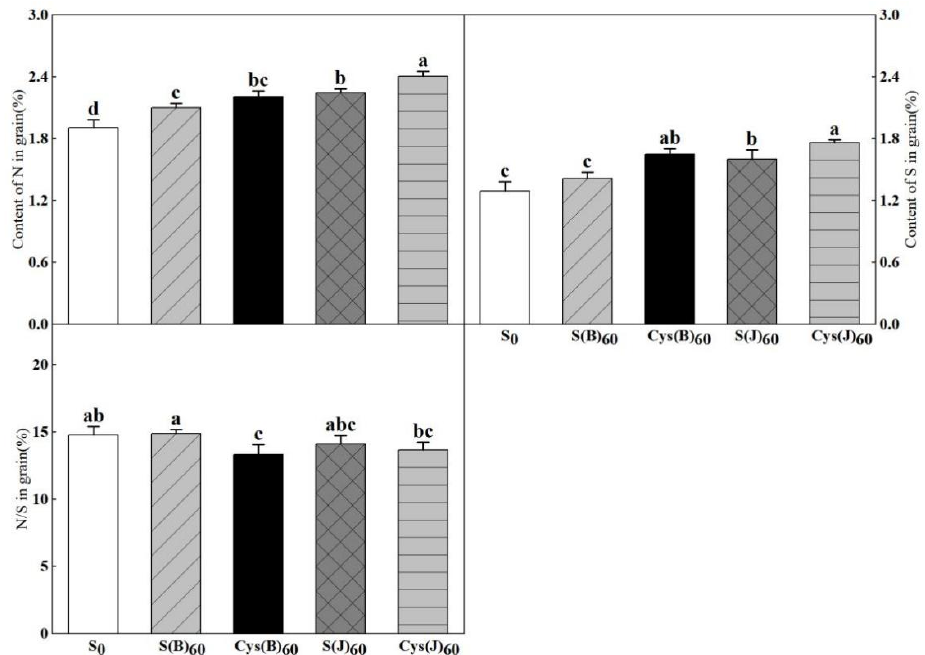
Figure 5. Effects of cysteine and inorganic sulfur at different stages on contents of nitrogen and sulfur content and the ratios of nitrogen to sulfur ratio in flour. Different small letters in the same column of each treatment are significantly different at a 0.05 probability level.